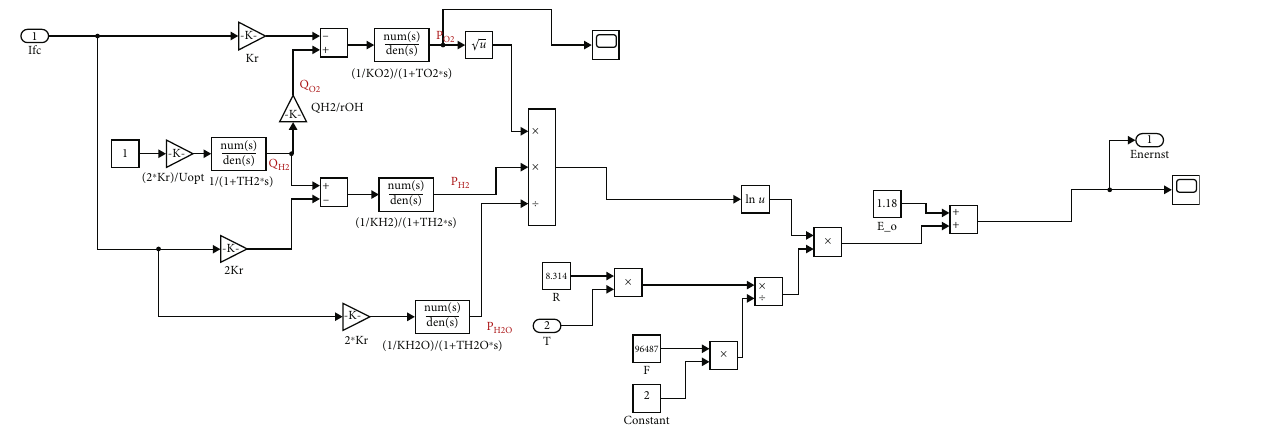
Figure 9: Simulink model of SOFC.